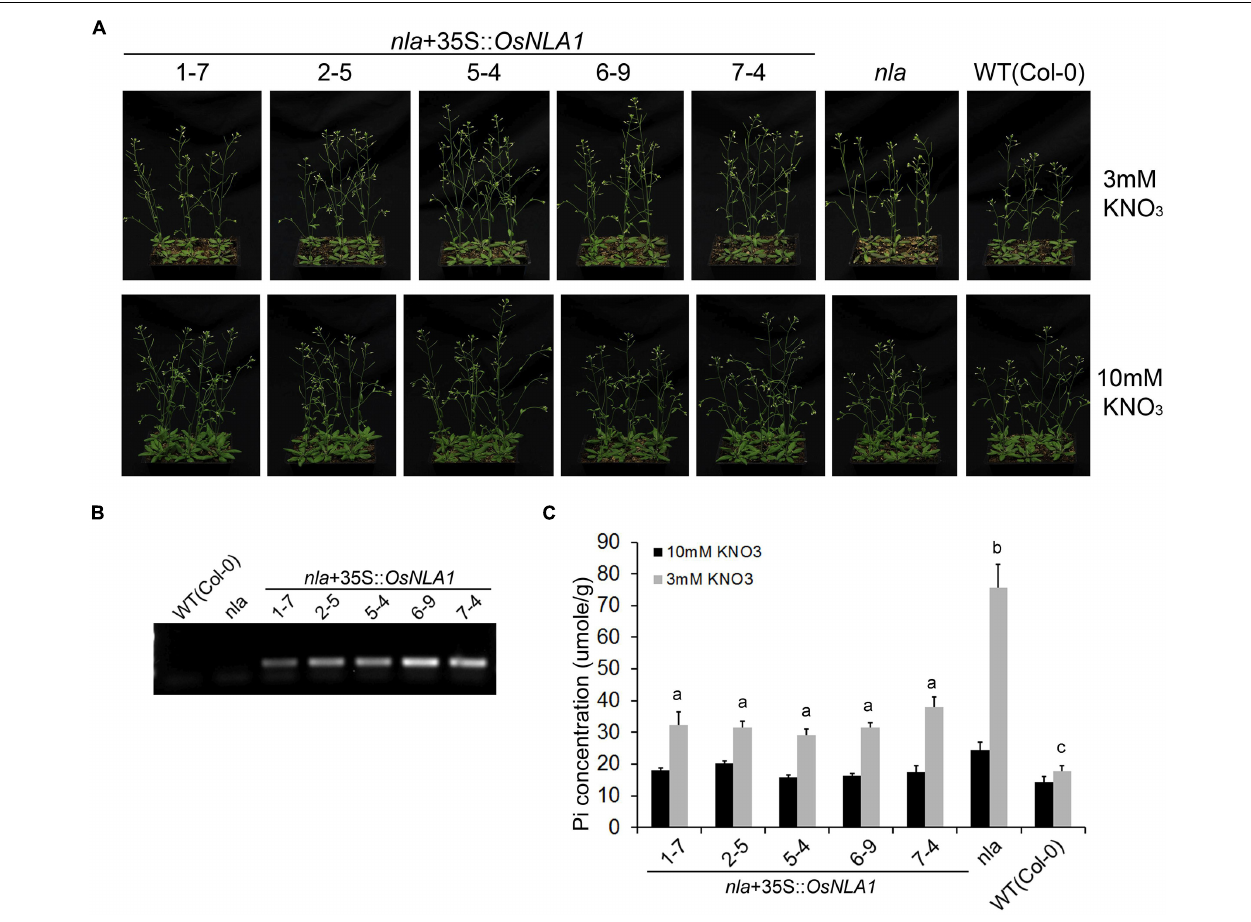
FIGURE 7 | Complementation of Arabidopsis nla mutants by OsNLA1 and the content of Pi in plants grown at optimum and low nitrate level. (A) Five independent transgenic lines, expressing OsNLA1 under 35S CaMV promoter in Arabidopsis nla background; plants were grown under nitrate sufficient (10 mM KNO 3 ) and limitation (3 mM KNO 3 ) conditions for 27 days. Under nitrate sufficient conditions, all plants grew normally without obvious early senescence symptoms. Under nitrate limitation conditions, nla mutant displayed early senescence. (B) The expression of OsNLA1gene in complemented lines, nla mutants and wild-type plants, analyzed by RT-PCR. Complemented lines showed varied levels of the expression of OsNLA1 gene. (C) Pi content ( µ mole/g FW) in the shoot of plants grown with sufficient and low nitrate levels. Different letters indicate a significant difference at P ≤ 0.05 level between genotypes with low nitrate treatment (ANOVA, LSD test). Data are means ± SE of four replicates ( n = 4).